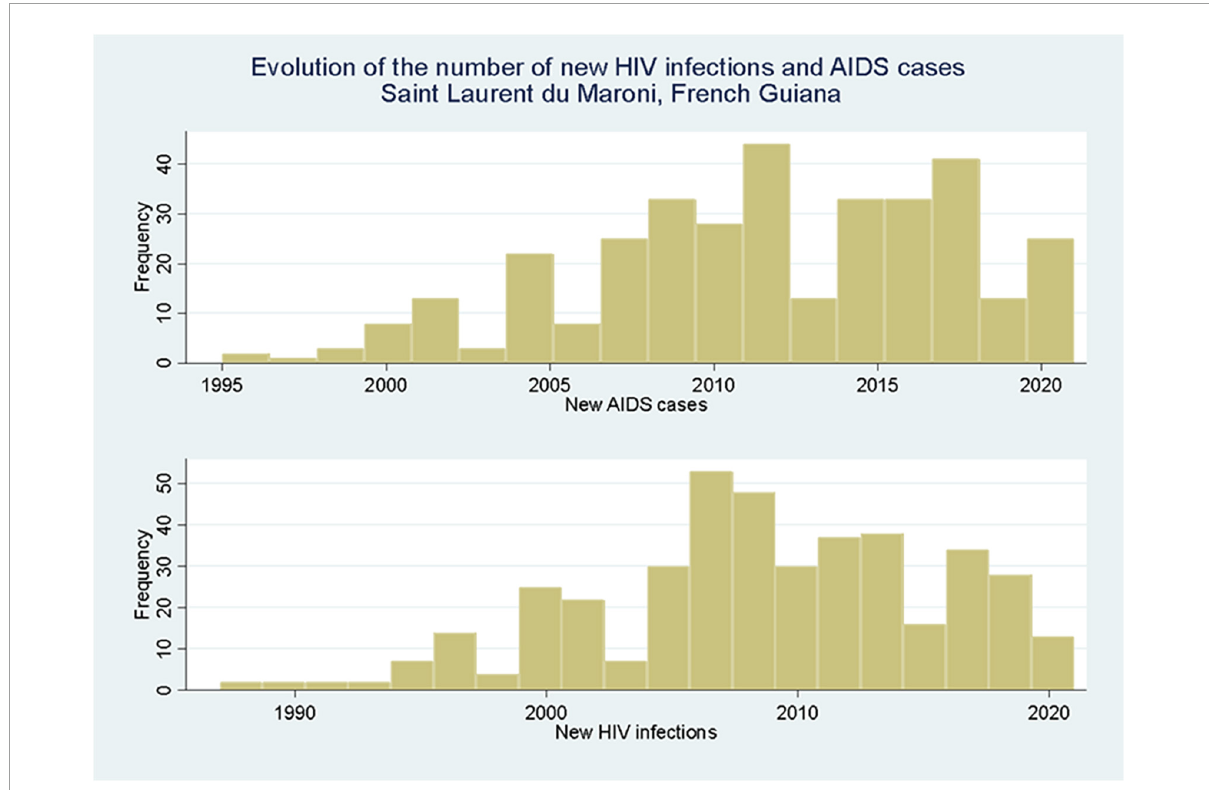
FIGURE5 New HIV infections and new AIDS cases in Saint Laurent du Maroni show a peak around 2010 with a slow decline thereafter.